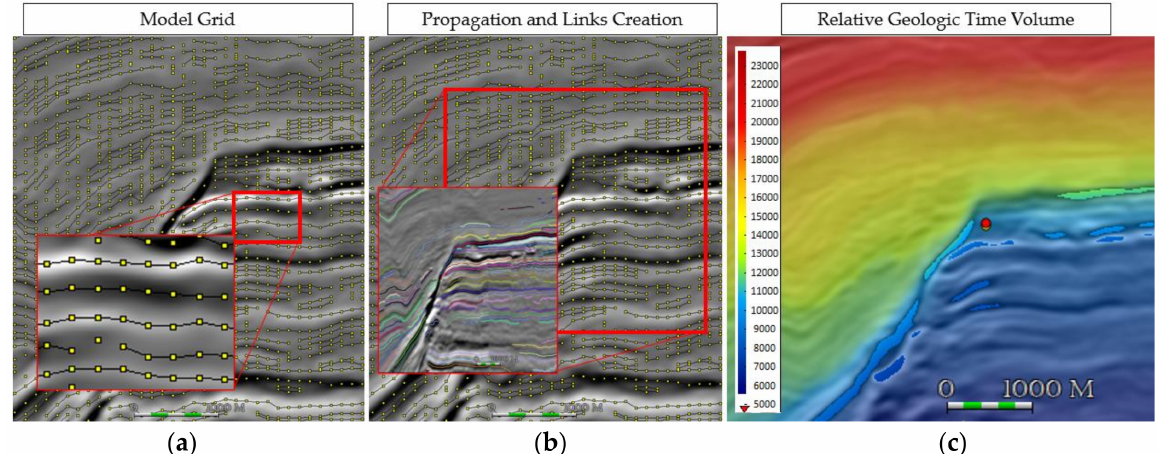
Figure 4. Modelling the relative geological time (RGT) modified from [23]. ( a ) Model-grid creation where each yellow node represents a small horizon patch with a limited size. ( b ) Links established in between nodes after propagation where the volume is composed of horizons with various size. ( c ) 3D continuous RGT model computed on the entire seismic volume based on the relationship of the